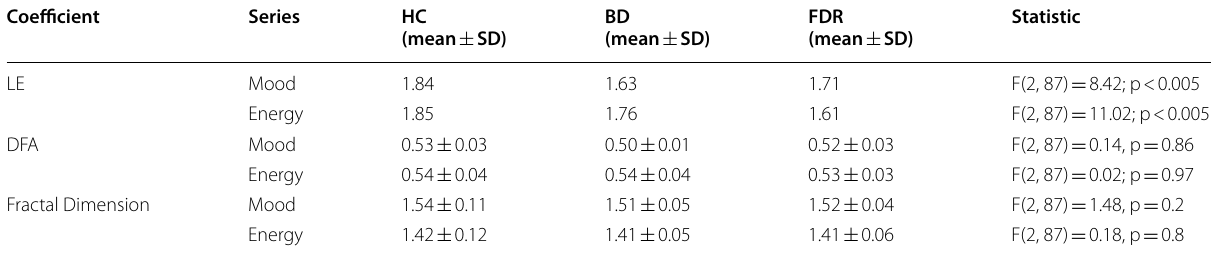
Table 2 Nonlinear coefficients for mood and energy